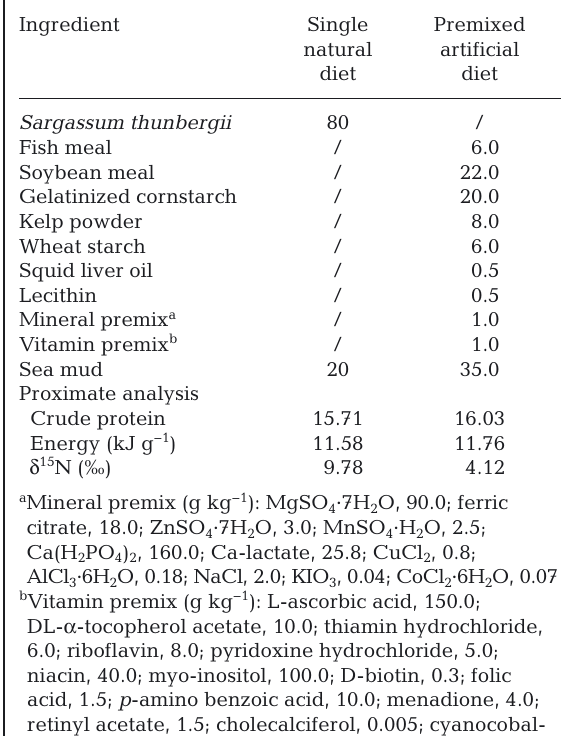
Table 1. Formulation and nutritional composition of the experimental diets (dry matter,